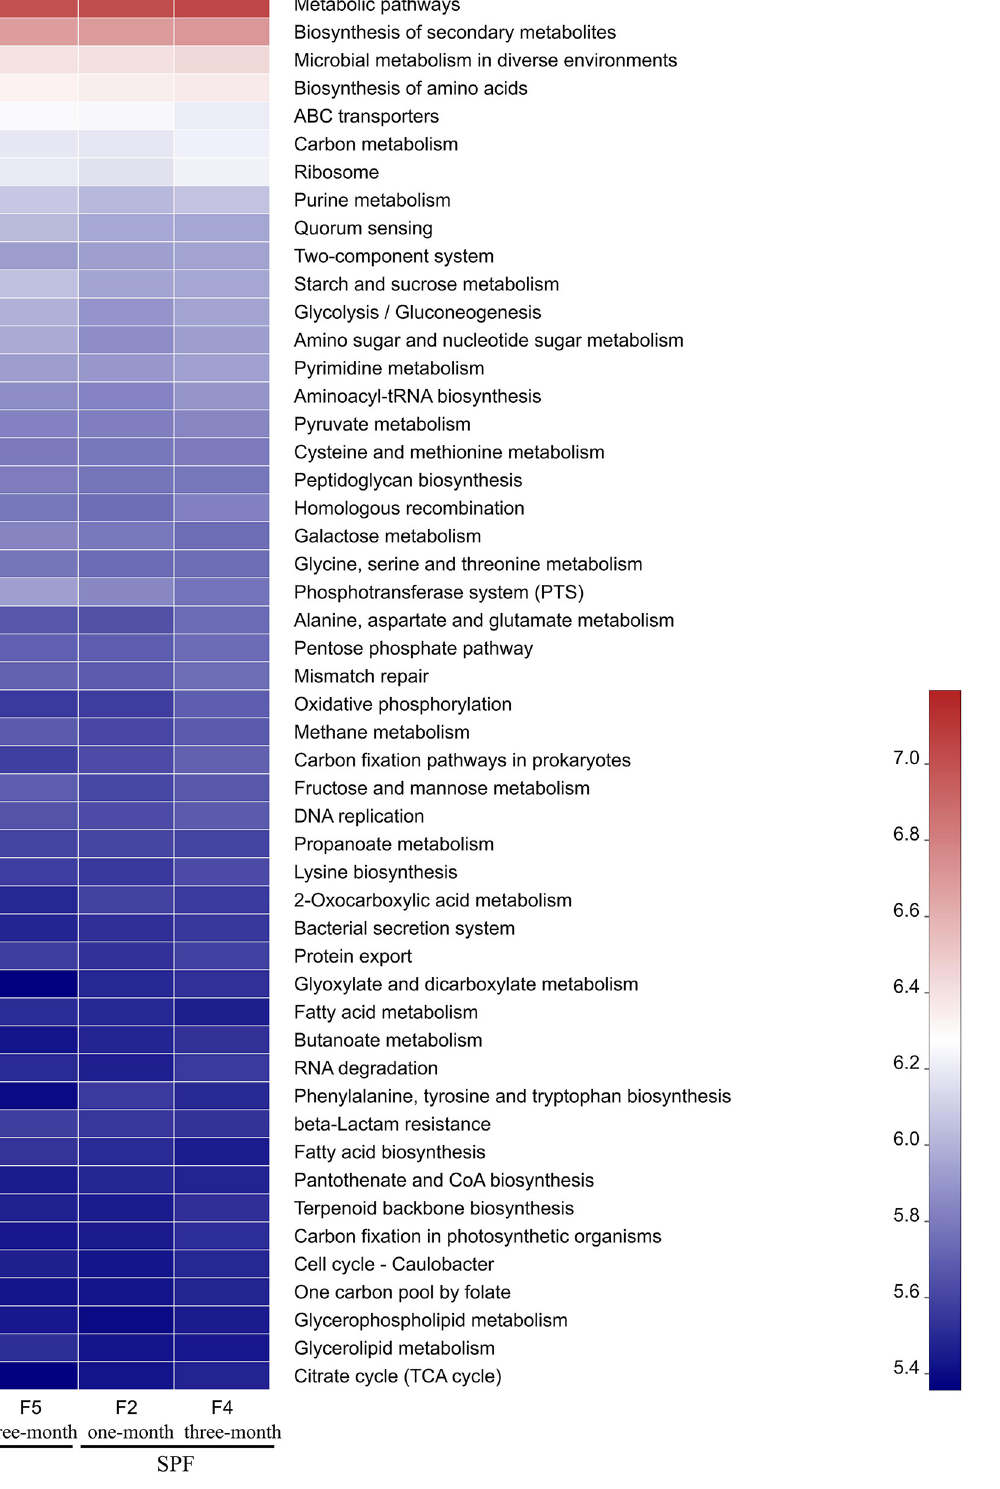
FIGURE3 The functional distribution of intestinal microbiota in non-SPF and SPF beagles. Abscissa is the group name, ordinate is the function name, and color gradient is used to show the changes of different function abundance in the group, and legend is the value represented by color